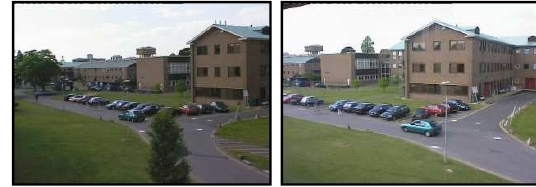
Figure 9: Some training videos with different views of the same scene surveillance [14].